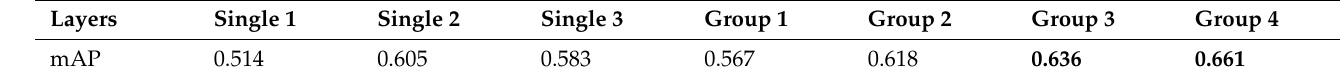
Table 4. Results of combining different convolutional